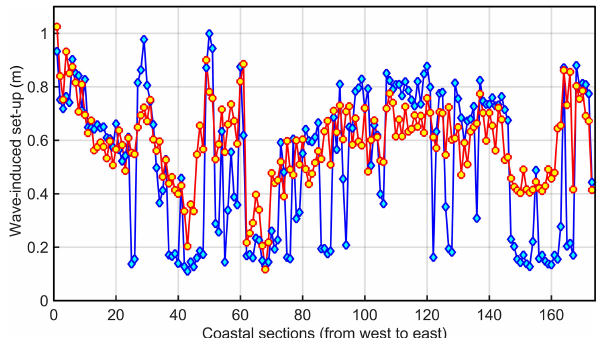
Figure 5. Maximum set-up heights evaluated using all onshore- propagating wave fields and Eqs. (1)–(8) (red circles) and similar heights evaluated using only those waves that approach the shore at an angle of less than ± 15 ◦ from shore normal (blue